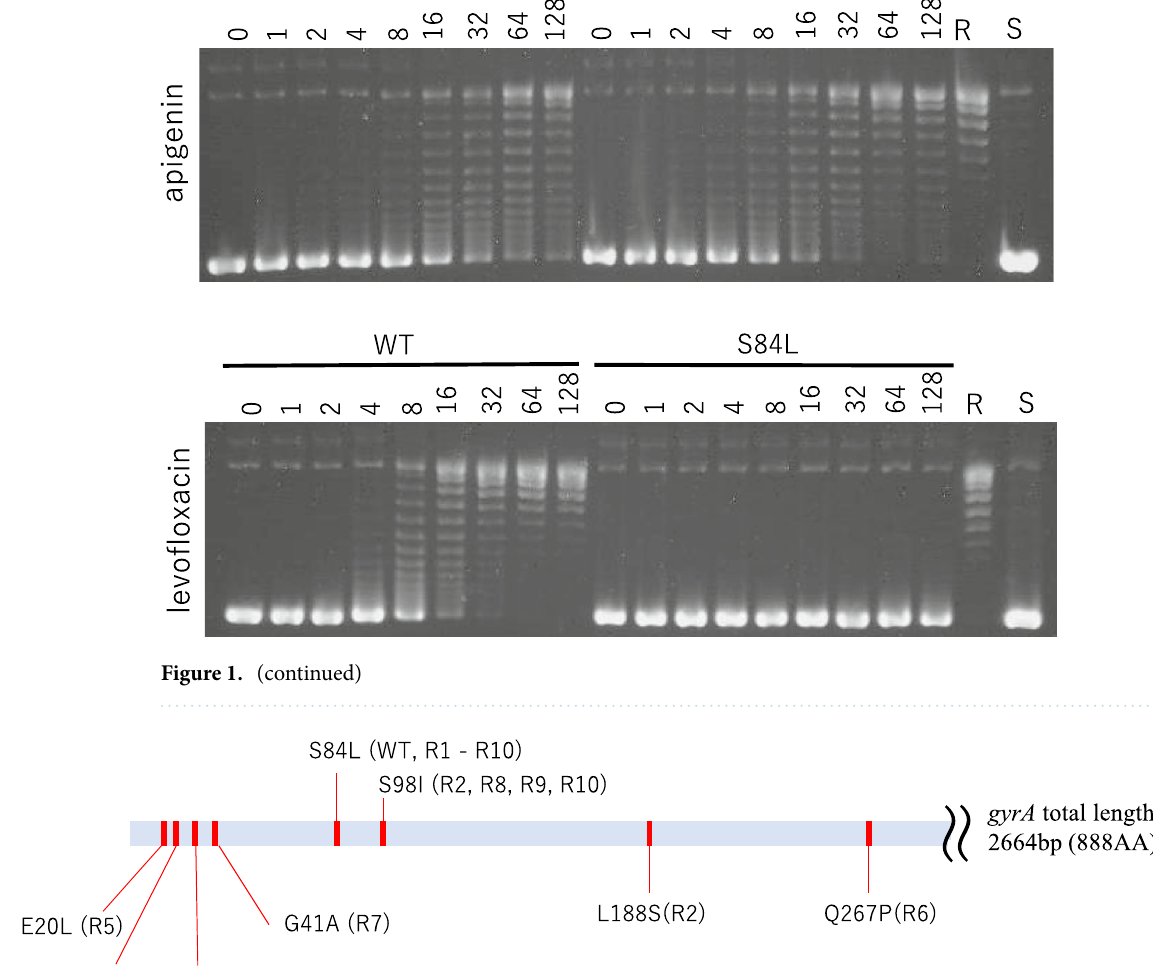
Figure 2. S. aureus strain Mu50 (WT) and CID12261165 mutant derivatives (R1 to R10) with various mutations in